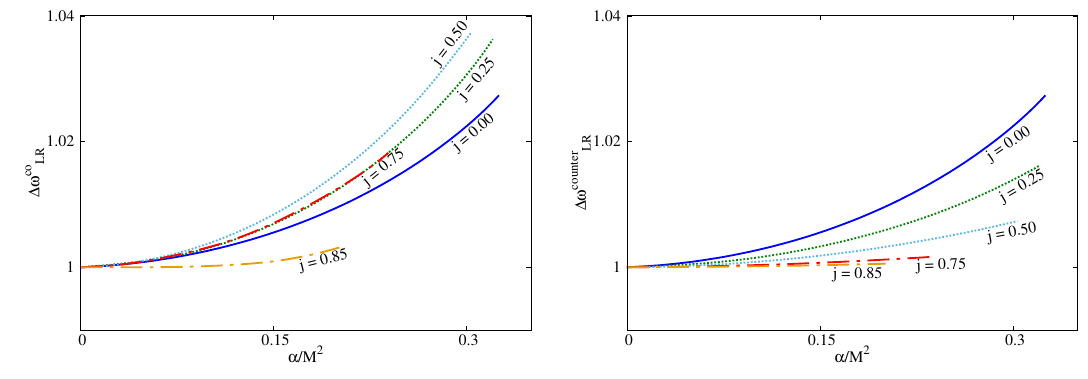
Figure 8 . Ratio between the angular frequency at the LR between EsGB BHs and Kerr BHs, for co-rotating orbits (left panel) and counter-rotating orbits (right